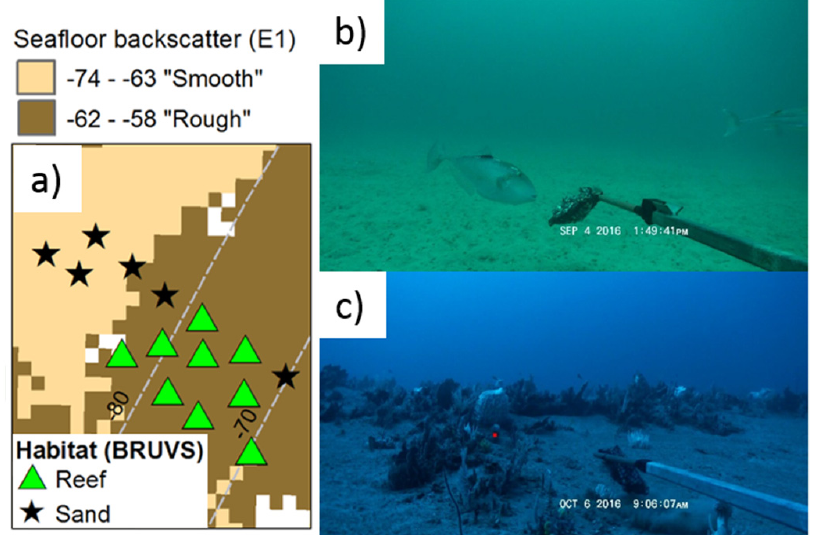
Figure 9. Benthic habitats present in the sampling points. ( a ) Classification of the benthic habitats based on the stereo-BRUV data over the seafloor backscatter. ( b ) Example of the bottoms classified as “Sand”. ( c ) Example of benthic habitat classified as “Reef” in the experiment at the Ningaloo Marine